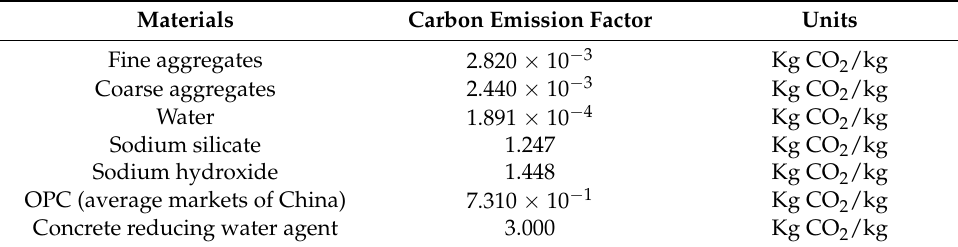
Table 1. Emission factors of raw materials from the Chinese Life Cycle Database (CLCD).